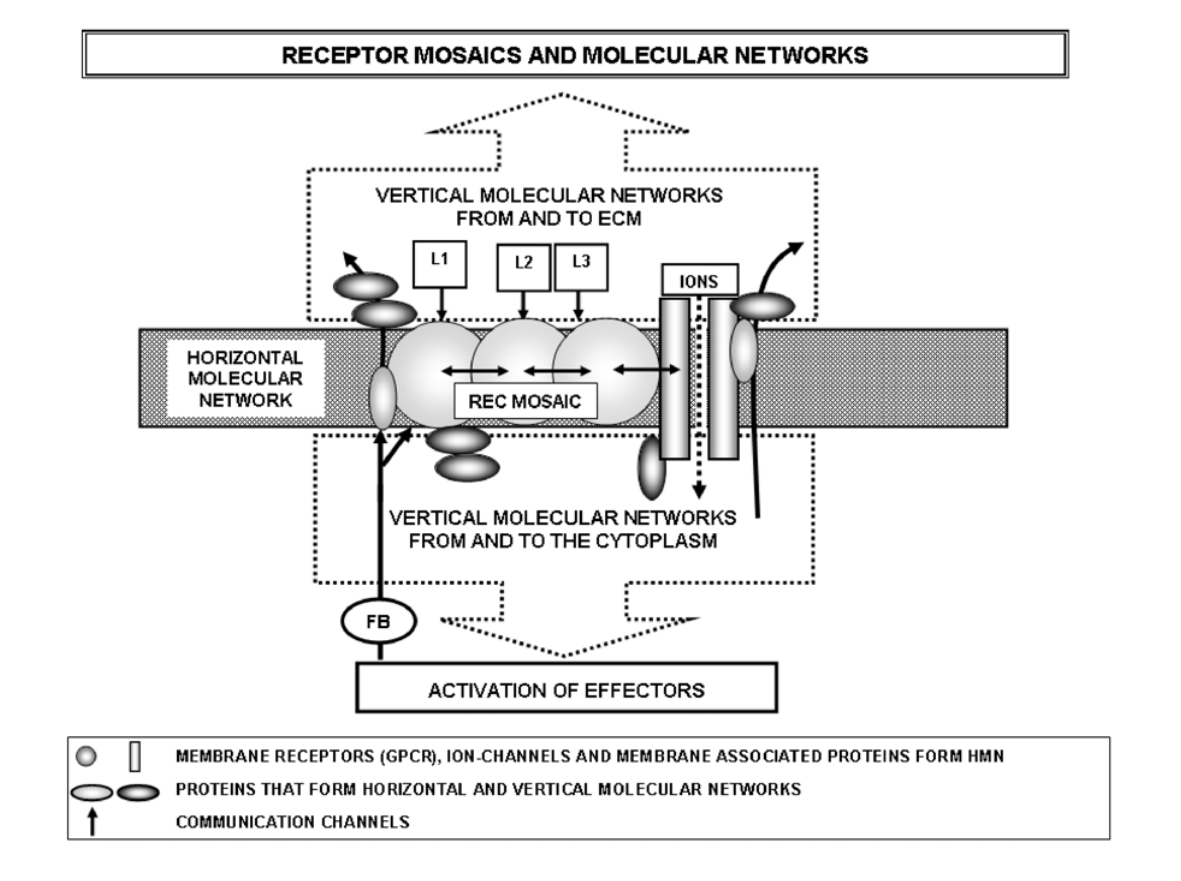
FIGURE 1 . Schematic representation of the concept of horizontal and vertical molecular networks and of receptor mosaics. For further details, see